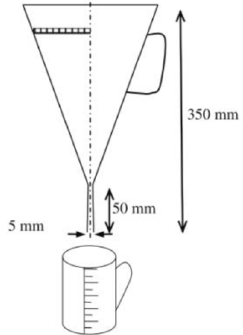
Figure 6. Illustration of the Marsh cone apparatus.